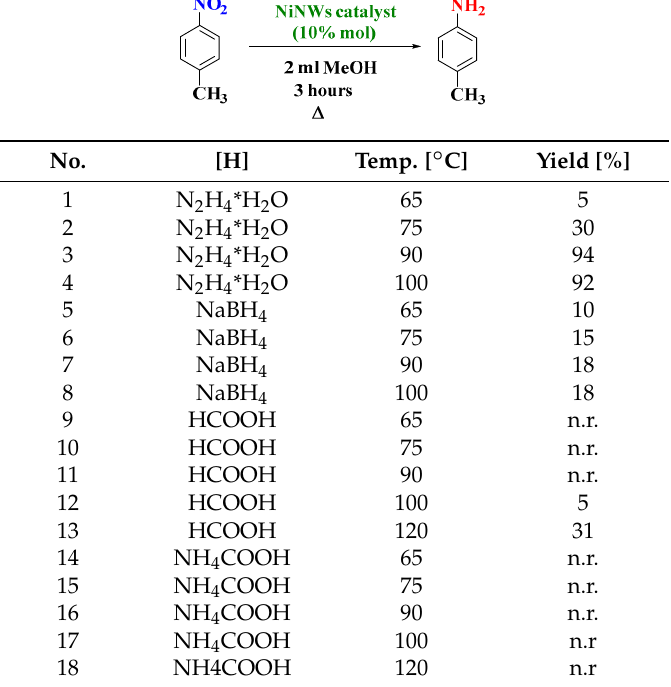
Table 5. Optimization of the reaction conditions a .